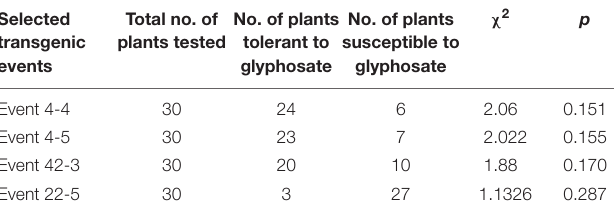
TABLE 2 | Transgene inheritance analysis in the selected transgenic